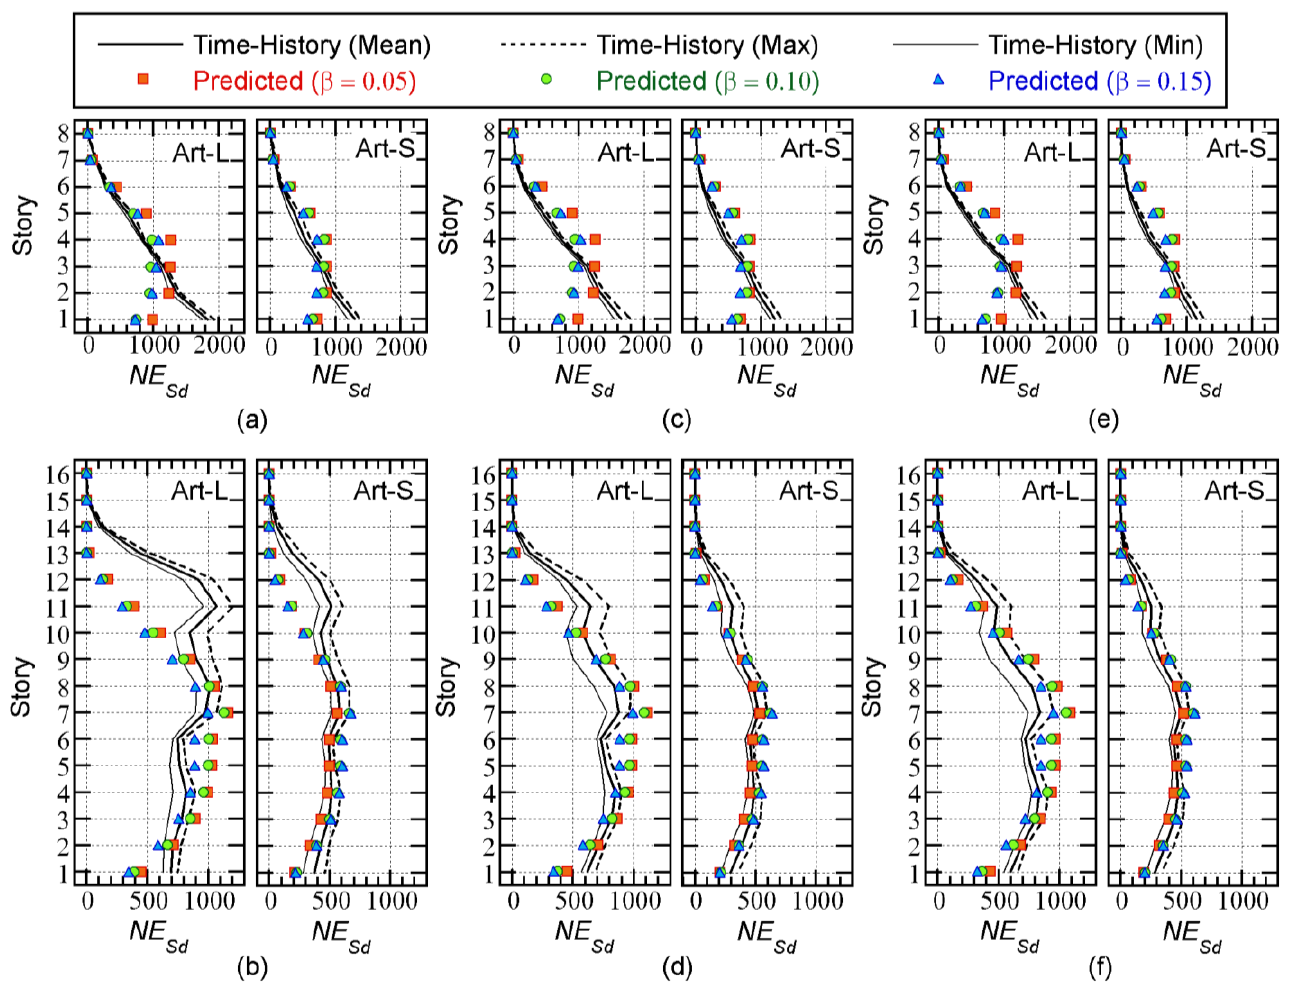
Figure 15. Comparisons of the normalized cumulative strain energy of the damper panels: ( a ) 8-story model ( h 1 f = 0.00); ( b ) 16-story model ( h 1 f = 0.00); ( c ) 8-story model ( h 1 f = 0.03); ( d ) 16-story model ( h 1 f = 0.03); ( e ) 8-story model ( h 1 f = 0.05); ( f ) 16-story model ( h 1 f =